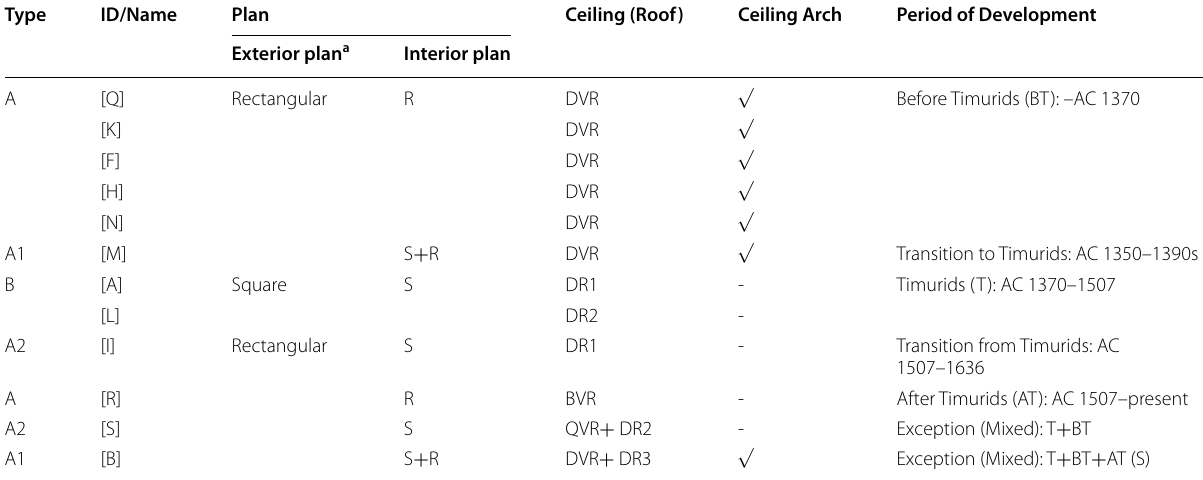
Table 3 Determining the period of